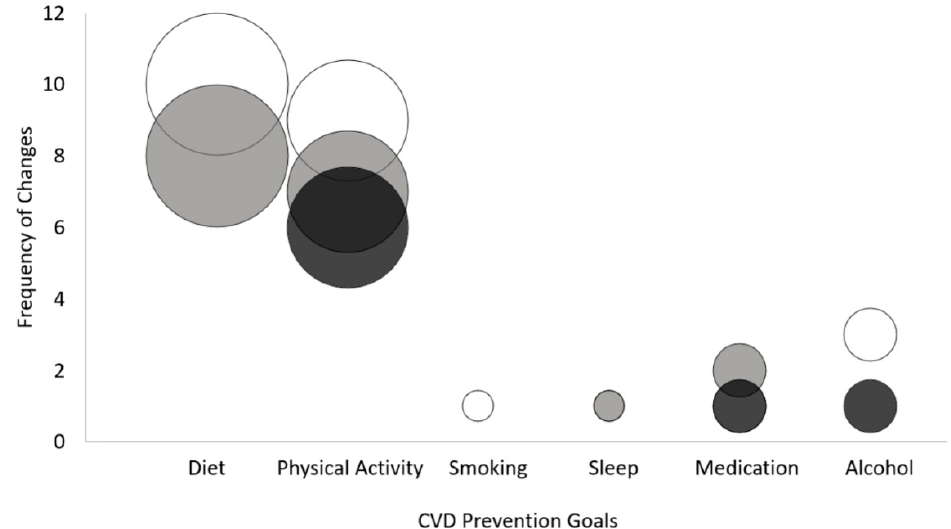
Figure 3. Bubble plot of the frequency of change and the type of change in patient behavioural goals throughout the CVD prevention program for every goal category. PA: physical activity. The x -axis lists the broader goal categories. The y -axis indicates the frequency of the subgoals within each category which experienced each change. The size of the bubbles indicates the popularity of the goal among patients. White, subgoals were continued; grey, subgoals were added; black, subgoals were adapted.